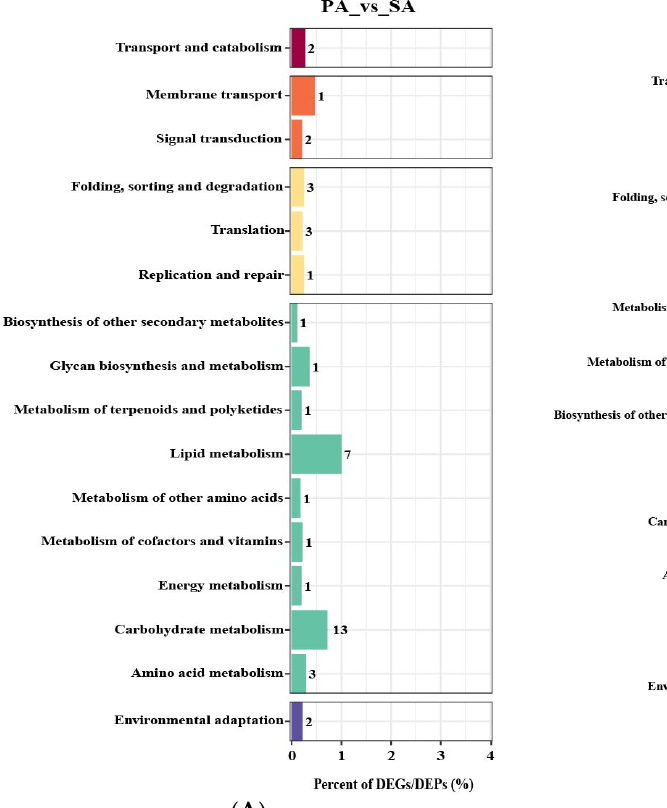
Table 1. Fold change related to the lipid metabolism DEGs/DEPs in peach/apricot (PA) and apri- cot/peach (AP). Pathway ID Gene